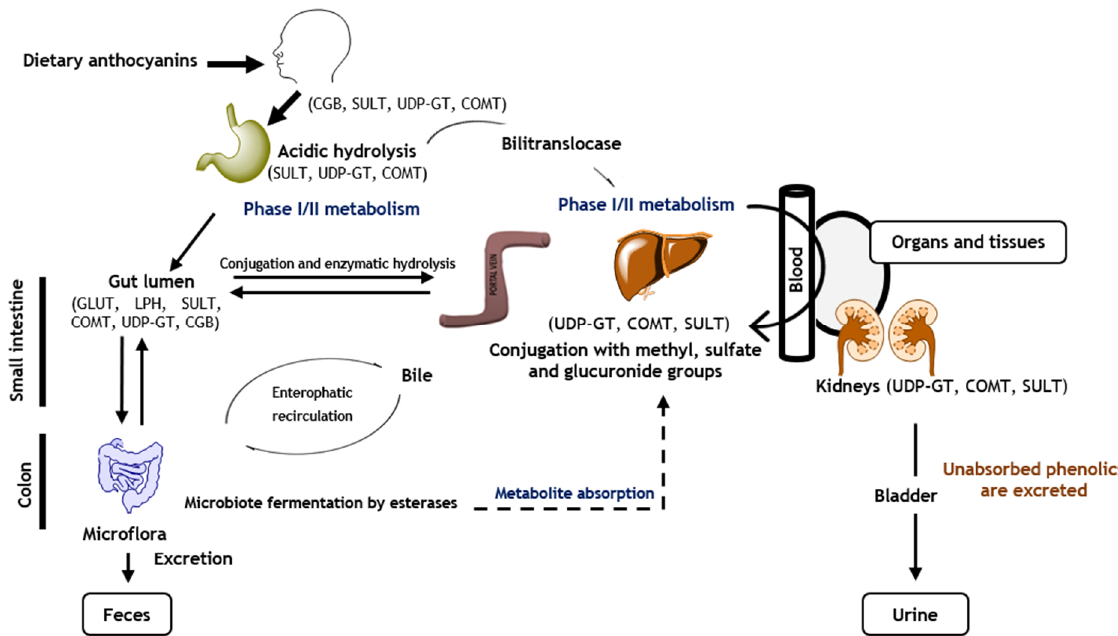
Figure 4. Anthocyanin absorption, distribution, metabolism, and excretion. CGB—cytosolic β -glucosidase; SULT—sulfotransferase; UDP-GT—glucuronosyltransferase; COMT—catechol- O -methyl transferase; GLUT—glucose transporters; LPH—lactase-phlorizin hydrolase.